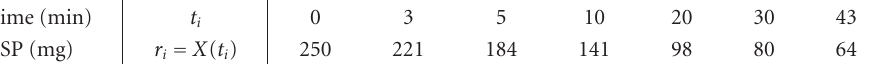
Table 1 . 1 . The amount of BSP in the blood.